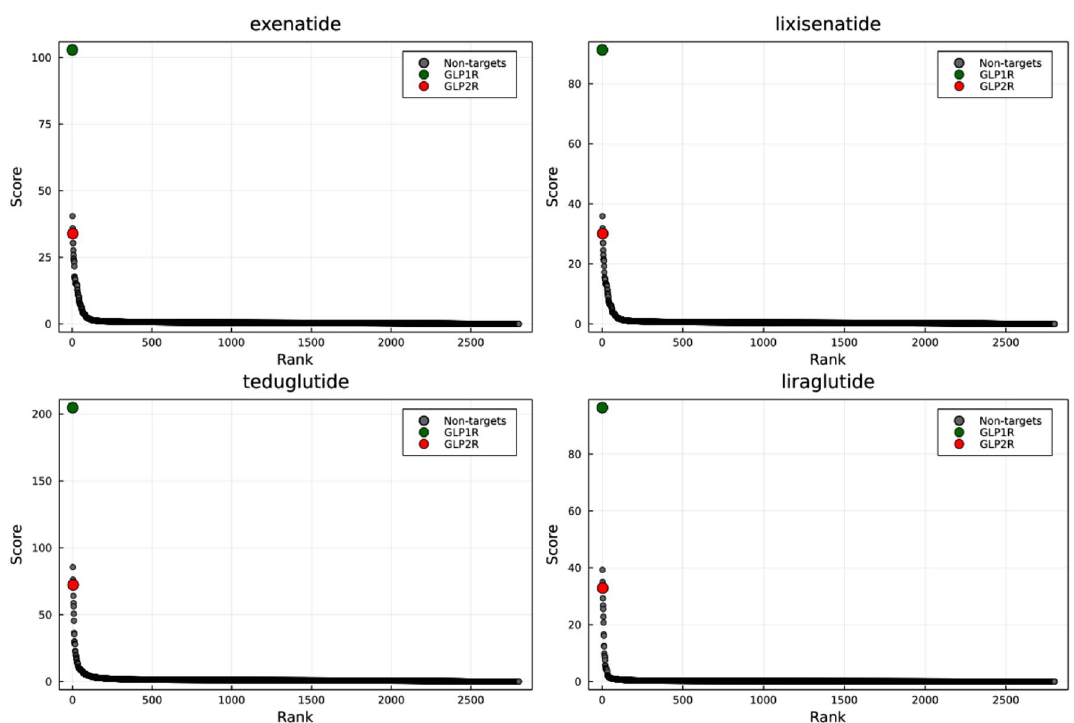
Figure 8. One-to-all curves of the peptides targeting a GLP receptor. Exenatide, liraglutide and lixsenatide target the GLP-1 receptor while teduglutide was developed to target the GLP-2 receptor. The curves were generated with SPRINT